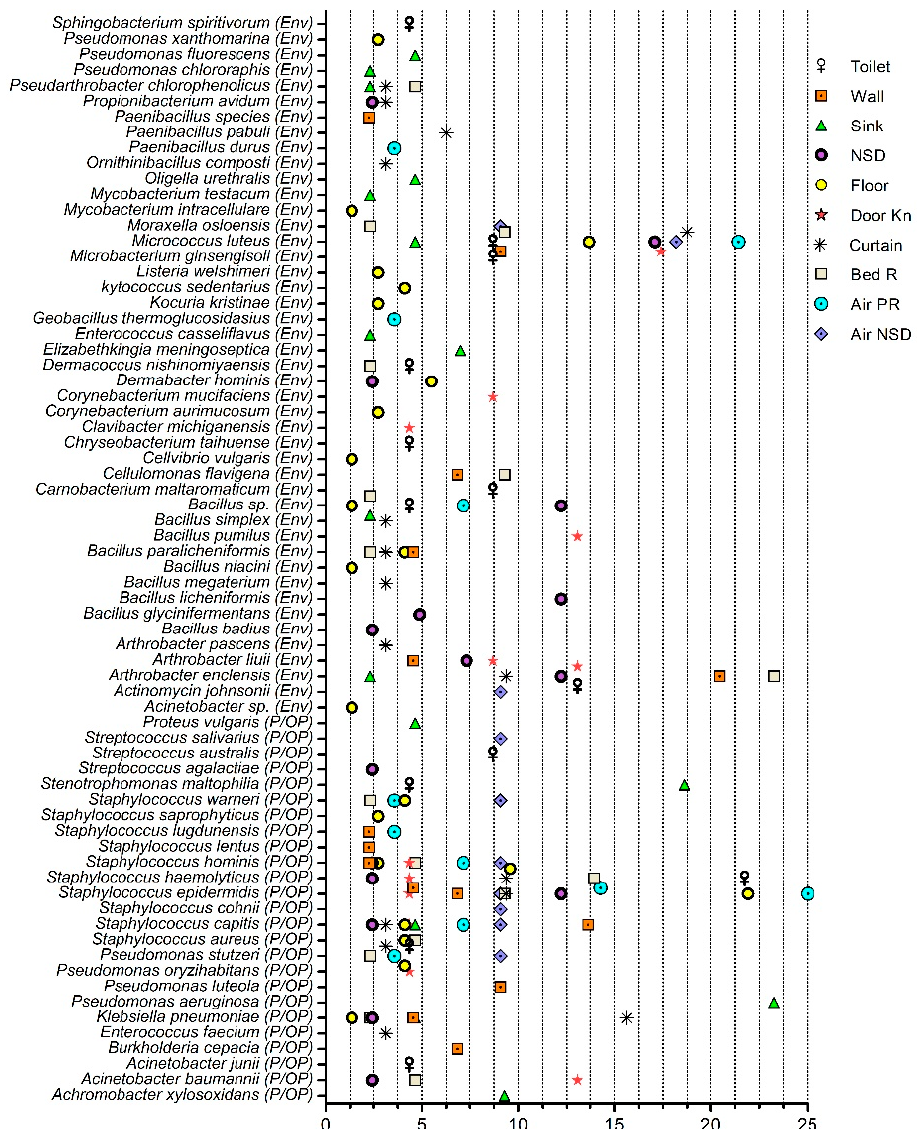
Figure 1. Distribution of environmental, pathogenic, and opportunistic pathogenic bacteria in the surface and air samples of the hospital units and nurses’ station desks. The x ‐ axis represents percentage abundance. Env, environmental; P/OP, pathogenic and opportunistic pathogen; NSD, nurses station desk; Door Kn, doorknob; Bed R, bed rail; Air PR, air patient room; Air NSD, air nurses station desk.